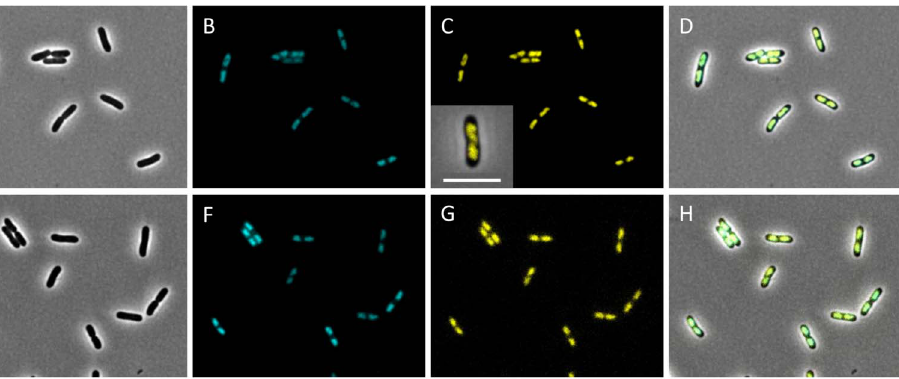
Figure 2. Representative images showing the colocalization of the IscR144::YFP and IolR159::YFP proteins with the DAPI stained nucleoid in LT2 iscR ::Mu d Y (A–D) and LT2 and iolR ::Mu d Y (E–H), respectively. Phase-contrast (A,E), DAPI (B,F), YFP (C,G), and merged (D,H) images are shown. Inset in panel C includes a larger image of an LT2 iscR ::Mu d Y cell showing the apparent helical shape of the nucleoid highlighted by IscR144::YFP. Scale bars correspond to 5 m m.